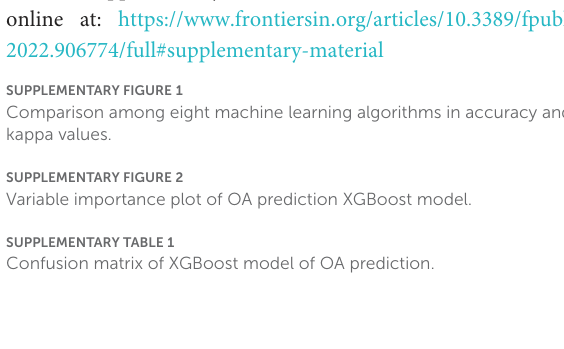
SUPPLEMENTARYFIGURE1 Comparison among eight machine learning algorithms in accuracy and kappa values. SUPPLEMENTARYFIGURE2 Variable importance plot of OA prediction XGBoost model. SUPPLEMENTARYTABLE1 Confusion matrix of XGBoost model of OA